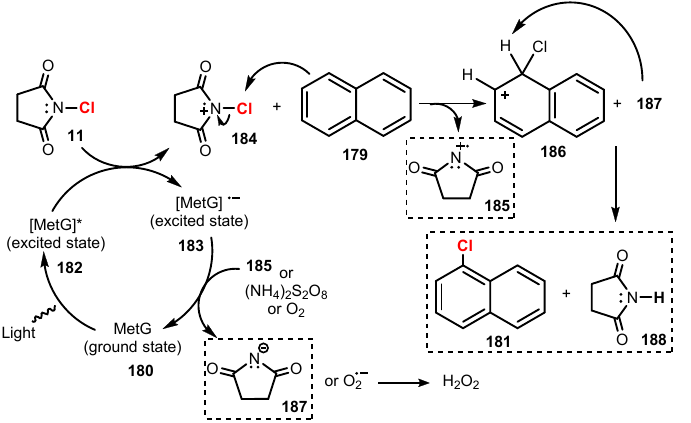
Scheme 50. Mechanism for chlorination of arenes and heteroarenes by N -chlorosuccinimide. Hammond and co-workers proposed a novel strategy for chlorination of arenes and heteroarenes using brilliant green (BG) in 2019 [54]. The chlorination was conducted via treatment of trichloroisocyanuric acid (TCCA) as a chlorine source in the presence of brilliant green (BG) under irradiation of white LEDs in acetonitrile (Scheme 51). For monosubstituted benzene, reactions of substrates with an electron-donating group smoothly afforded the corresponding products with high yields (74–92%) ( 192a – b ), while the chlorination of substrates with an electron-withdrawing group such as nitrobenzene ( 192c